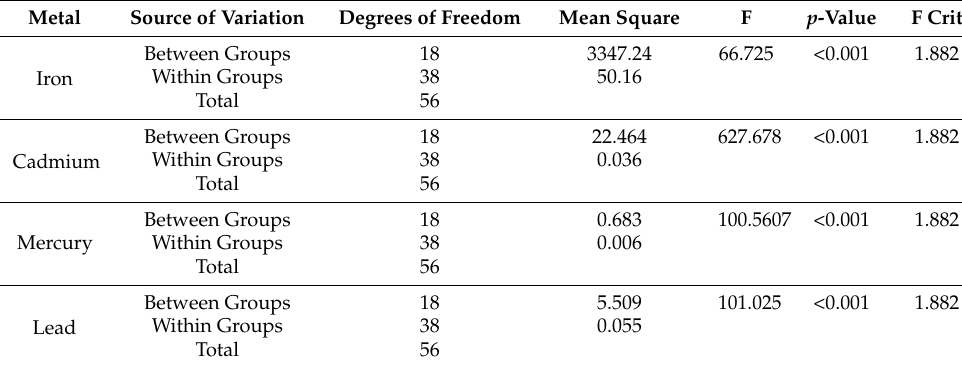
Table 8. Analysis of variance of iron, cadmium, mercury and lead contents in a panel of 19 mushroom- based supplements between the mean values determined on 3 different